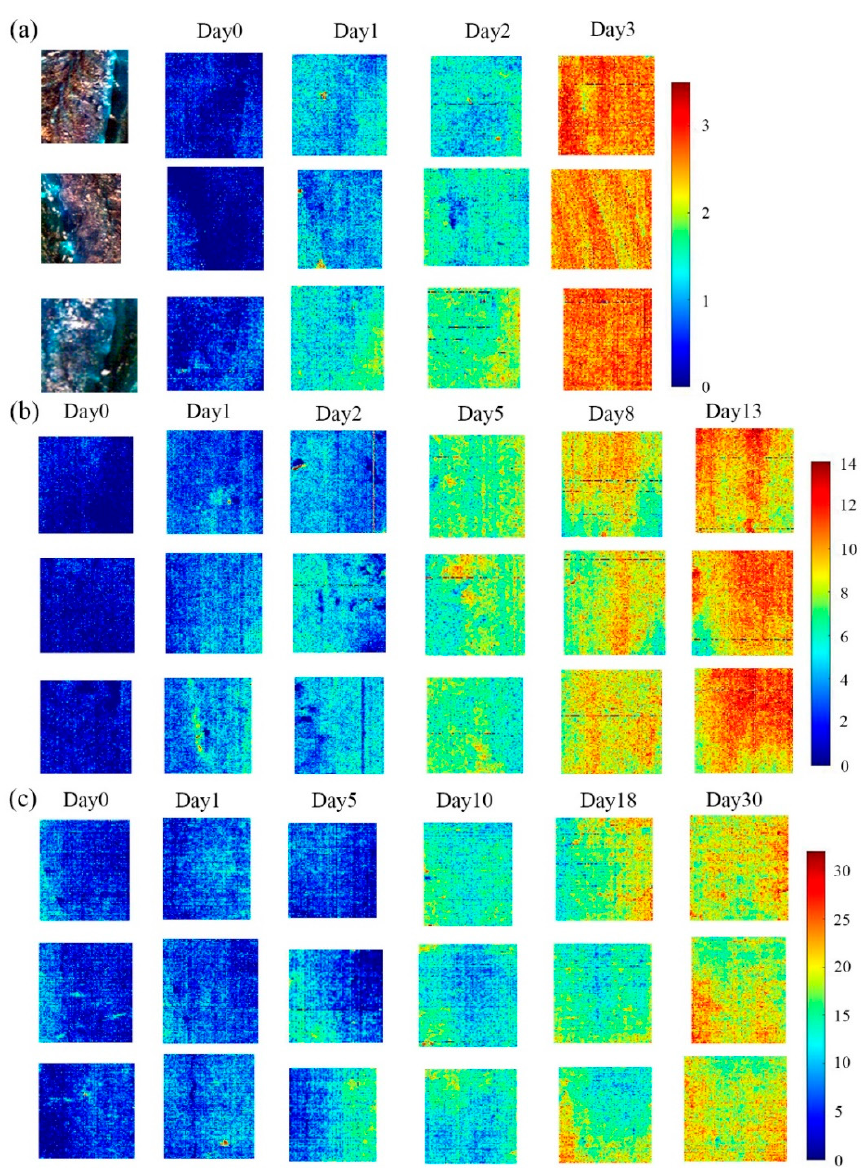
Figure 5. Visualization of storage time under different storage conditions: ( a ) Room temperature; ( b ) refrigeration; ( c ) freeze.